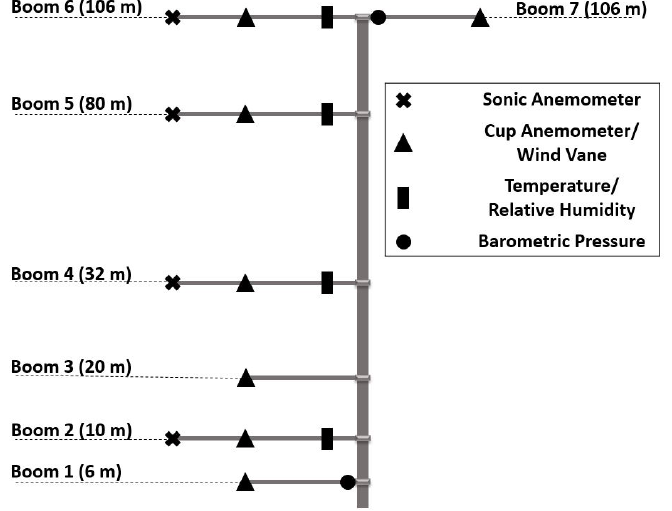
Figure 7. A schematic of the sensors installed on the 106 m tall met tower at the site. The instruments are installed on seven booms, at six different heights. Six booms are extended towards the west while Boom 7 extends